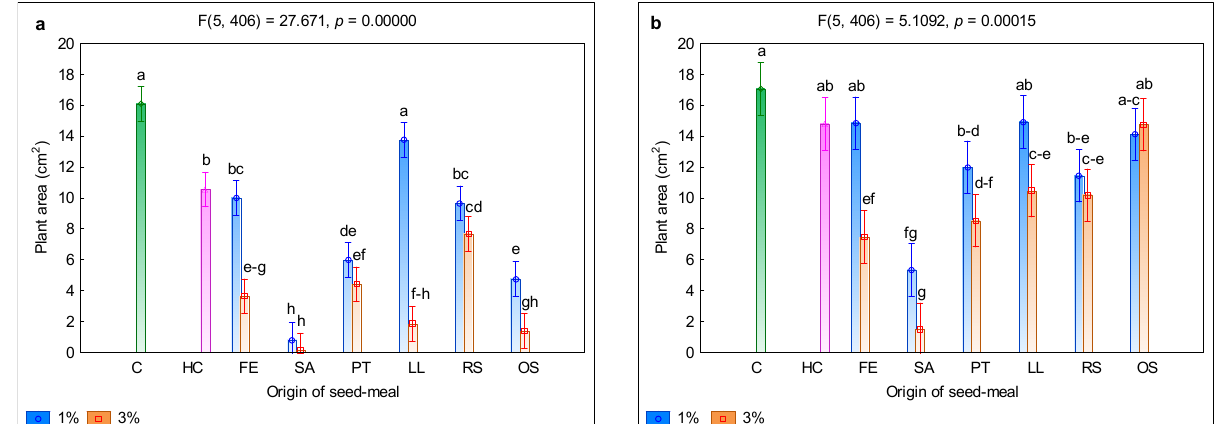
Figure 4. The mean aboveground surface area of herbicide-susceptible ( a ) and -resistant ( b ) biotypes of wild oat depending on the origin of seed meals and their concentration. Means with various letters are significantly different, according to Tukey test ( p ≤ 0.05). Vertical bars mean 0.95 confidence intervals. The symbols mean C—control, HC—herbicide control, and seed meals from FE— Fagophyrum esculentum , SA— Sinapis alba , PT— Phacelia tanacetifolia , LL— Lupinus luteus , RS— Raphanus sativus , OS— Ornithopus sativus . The column colors mean green—control, pink—herbicide control, blue—1% concentration of seed meals, orange—3% concentration of seed meals. The surface area of the aboveground parts was only 0.12–0.80 cm 2 , for seed meals SA3 and SA1, respectively; while in the C, it was over 16 cm 2 . In addition, the majority of